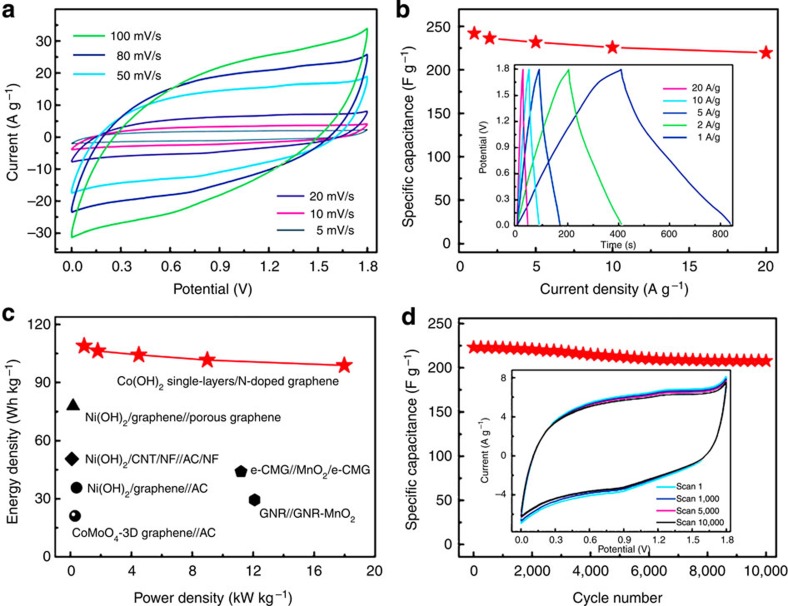
Performance of the β-Co(OH)2 nanosheet-based supercapacitor.(a) Cyclic voltammetry (CV) curves at various scan rates and (b) galvanostatic charge–discharge curves at different current densities (inset) and the corresponding calculated specific capacitances of the single-layer β-Co(OH)2 nanosheet-based all-solid-state asymmetric supercapacitor. (c) Comparison of the electrochemical performance with previously reported asymmetric supercapacitors. (d) Cycling performance of the fabricated single-layer β-Co(OH)2 nanosheet-based all-solid-state asymmetric supercapacitor measured at a scan rate of 20 mV s−1. Inset: the corresponding CV curves. Reproduced, with permission, from ref. 80 (© 2014 John Wiley & Sons Inc).